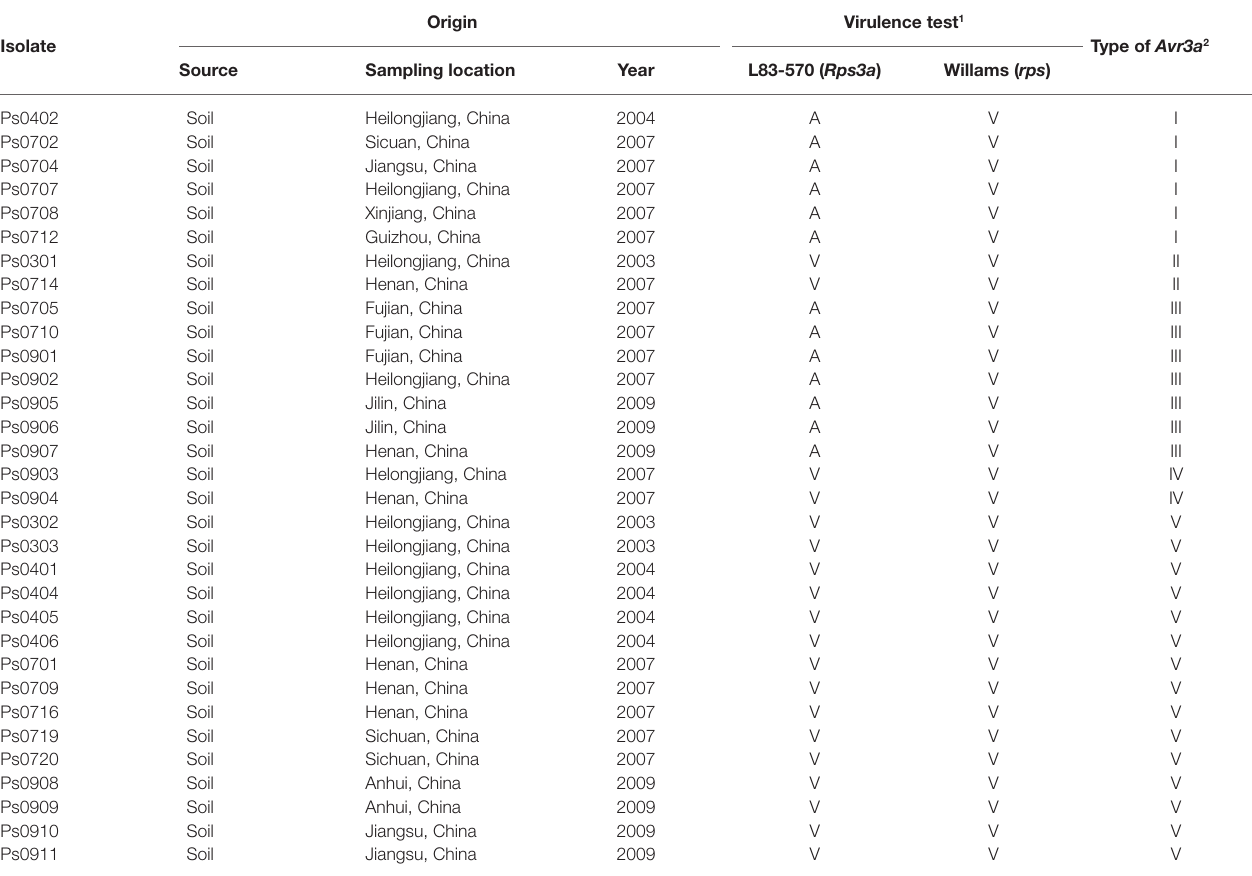
TABLE 1 | Virulence of Phytophthora sojae isolates to Rps3a and the Avr3a alleles.